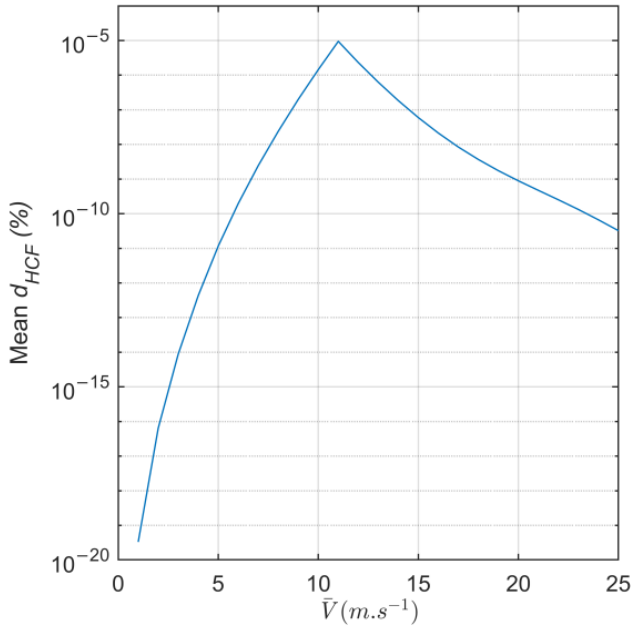
Figure 10. Mean WTB damage d HCF regarding a generated 1 Hz wind speed signal for a 10-min period as function of the V with a fixed TI = 10%.